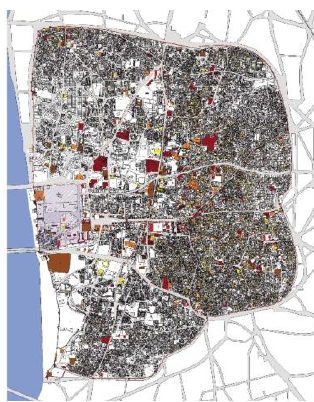
Figure 4 – Historic city of Ahmadabad with